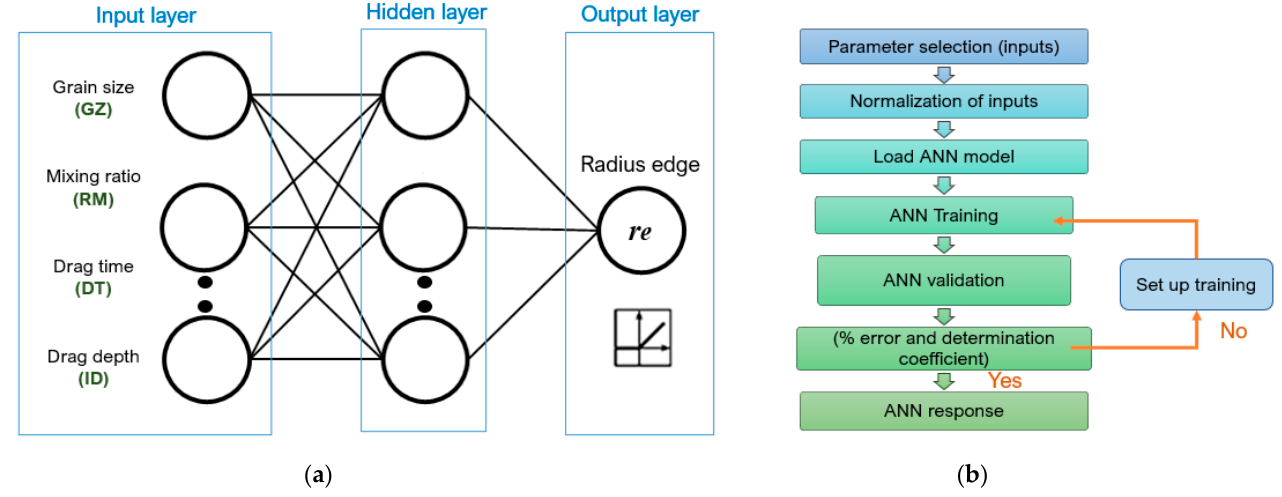
Figure 3. Characterization of the honed cutting edge. ( a ) network layout; ( b ) flowchart .